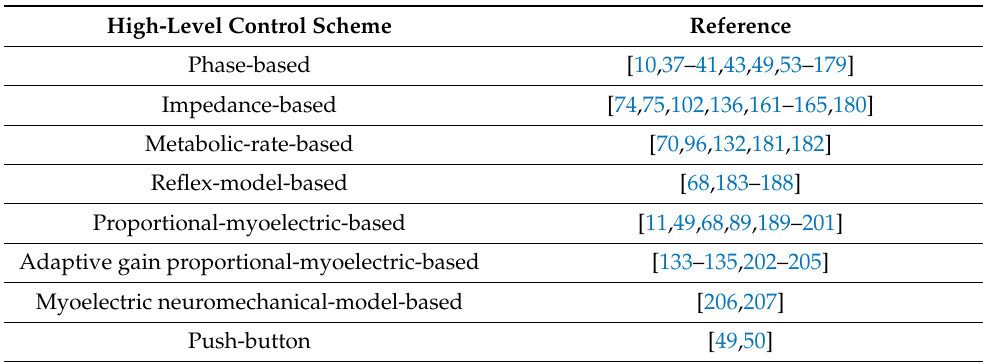
Table 2. High-level control strategies used in